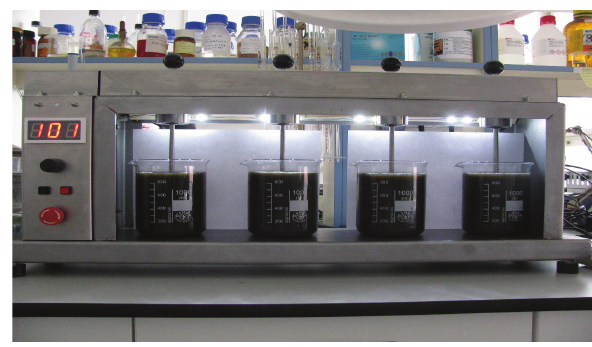
Figure 1: Flocculator (R-vizija,